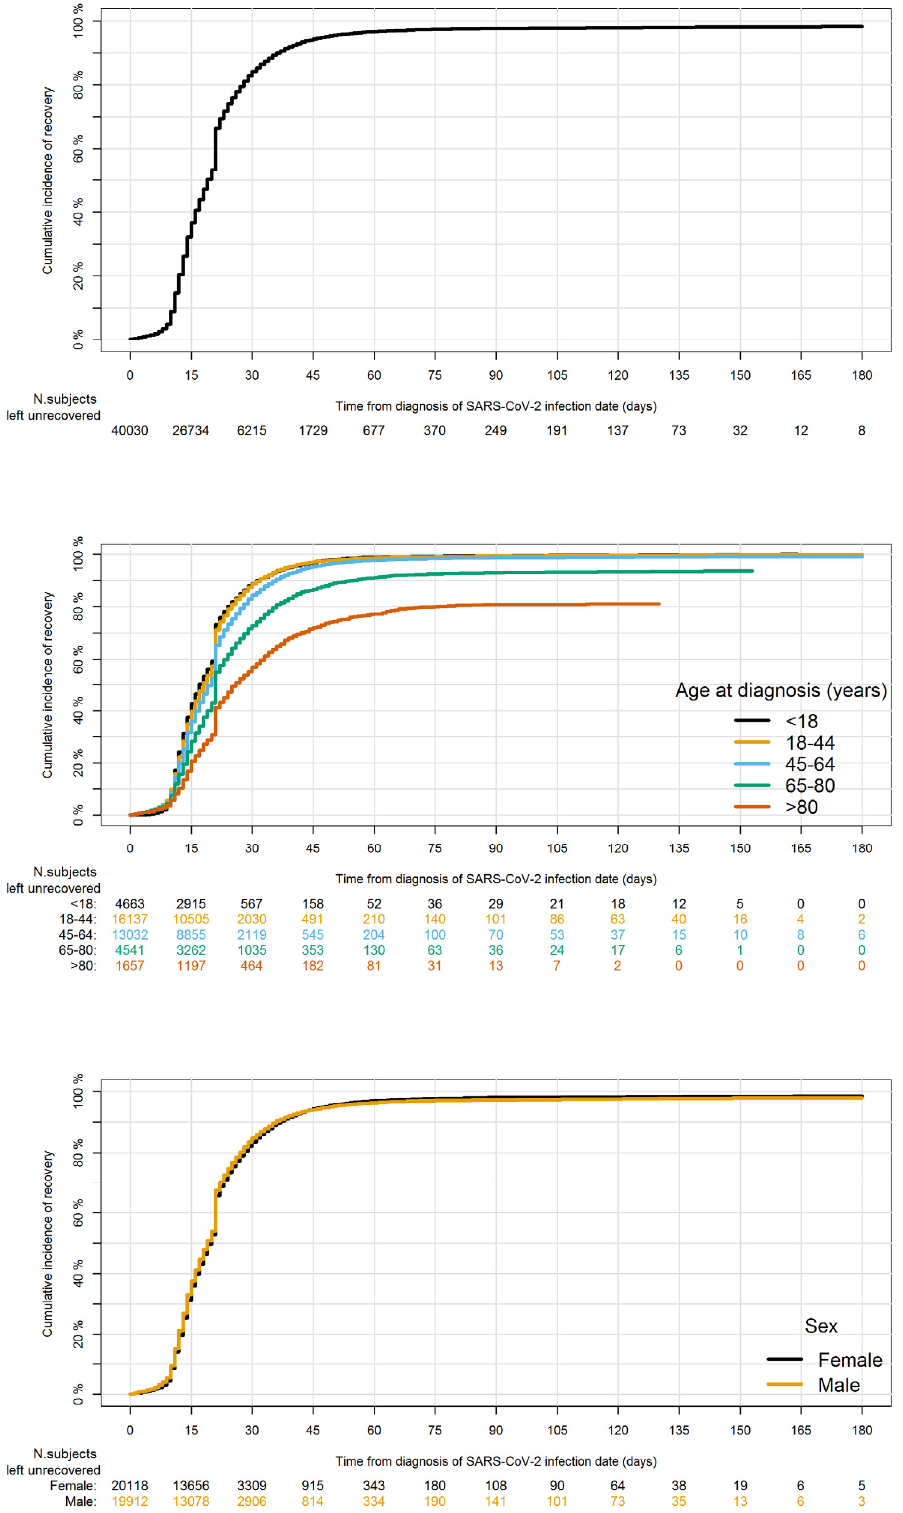
Figure 5. Cumulative recovery rate within 180 days from the first laboratory-confirmed SARS-CoV-2 infection diagnosis date in Caserta Local Health Unit in the period 21 February 2020–2 April 2021, in the overall population and stratified by age at diagnosis groups and sex.